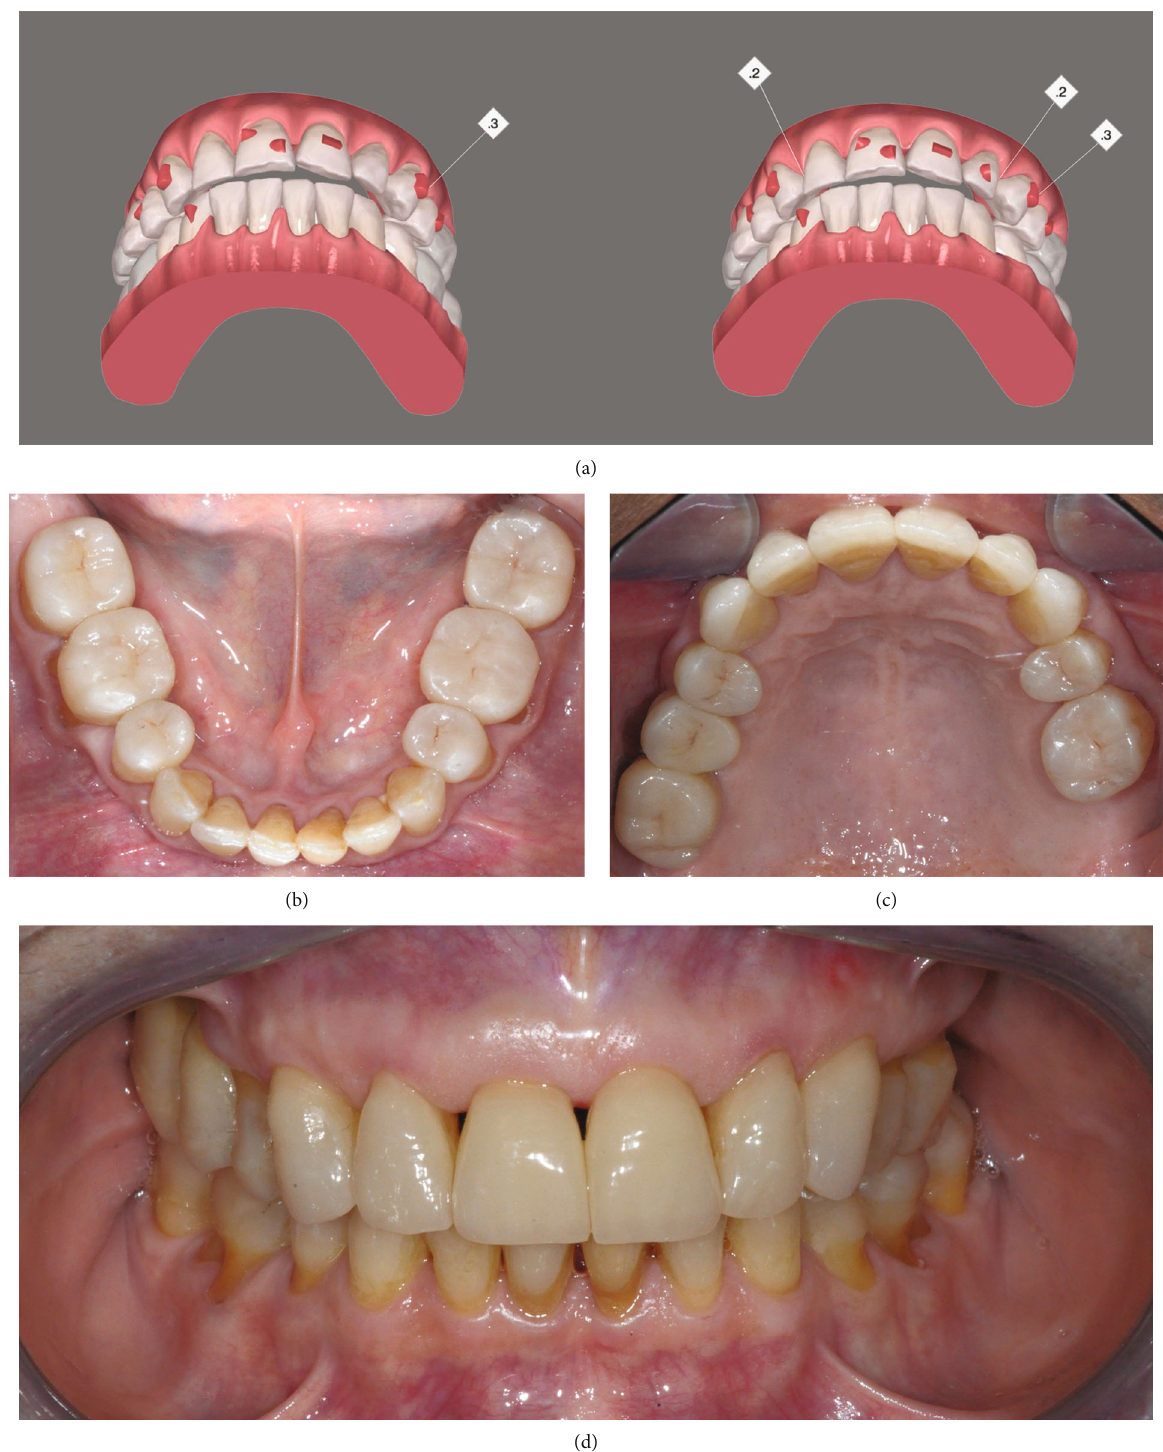
Figure 2: Sectional clear aligner therapy and fi nal restorations. (a) 3D alignment simulation through ClinCheck software showing attachments bonded on teeth 1.1, 1.3, 1.4, 2.1, 2.2, 2.3, 2.4, and 4.3 and interproximal enamel reduction required on teeth 1.3, 2.3, 2.4, and 2.6. ((b) – (d)) Post-operative occlusal and frontal views. The main movements achieved after the clear aligner therapy were: derotation on teeth 1.1, 1.3, 1.4, 2.2, 2.3, and 4.3; tipping increase on tooth 2.1; torque increase on tooth